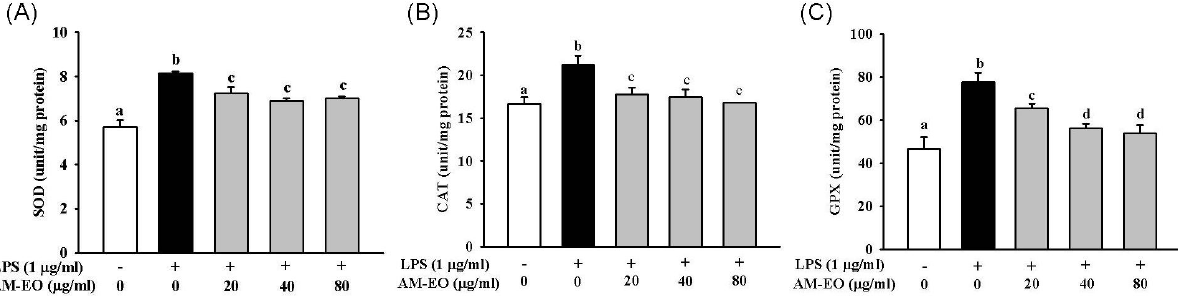
Figure 4. The effect of AM-EO on ( A ) superoxide dismutase (SOD), ( B ) catalase (CAT) and ( C ) glutathione peroxidase (GPx) production by LPS-induced RAW 264.7 macrophages. Each value represents the mean ± SD ( n = 3). Groups sharing the same superscript letter are not significantly different ( p > 0.05) as revealed by